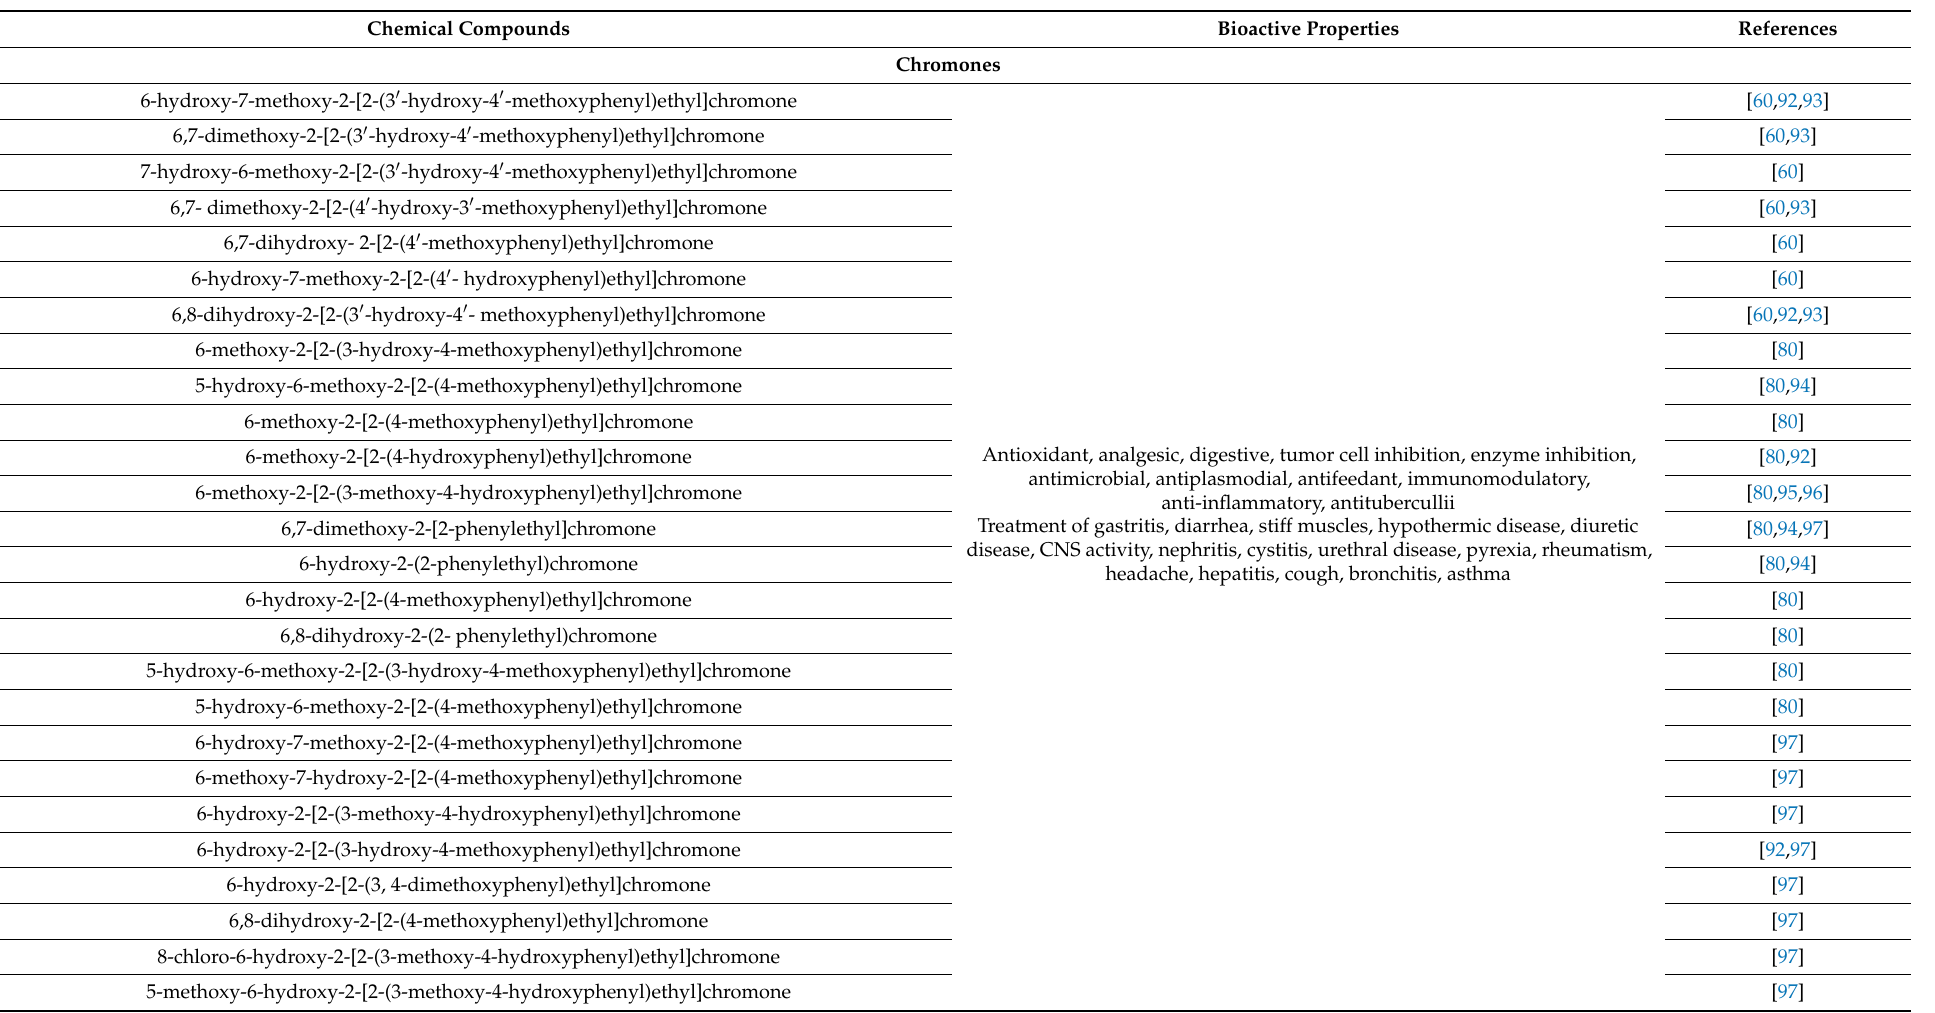
Table 3. List of chromones and terpenoids known to be extracted from agarwood obtained from Aquilaria sinensis , A. malaccensis, A. filaria , and Gyrinops versteegii (as reported by Wang et al. [91] and Yuan et al.